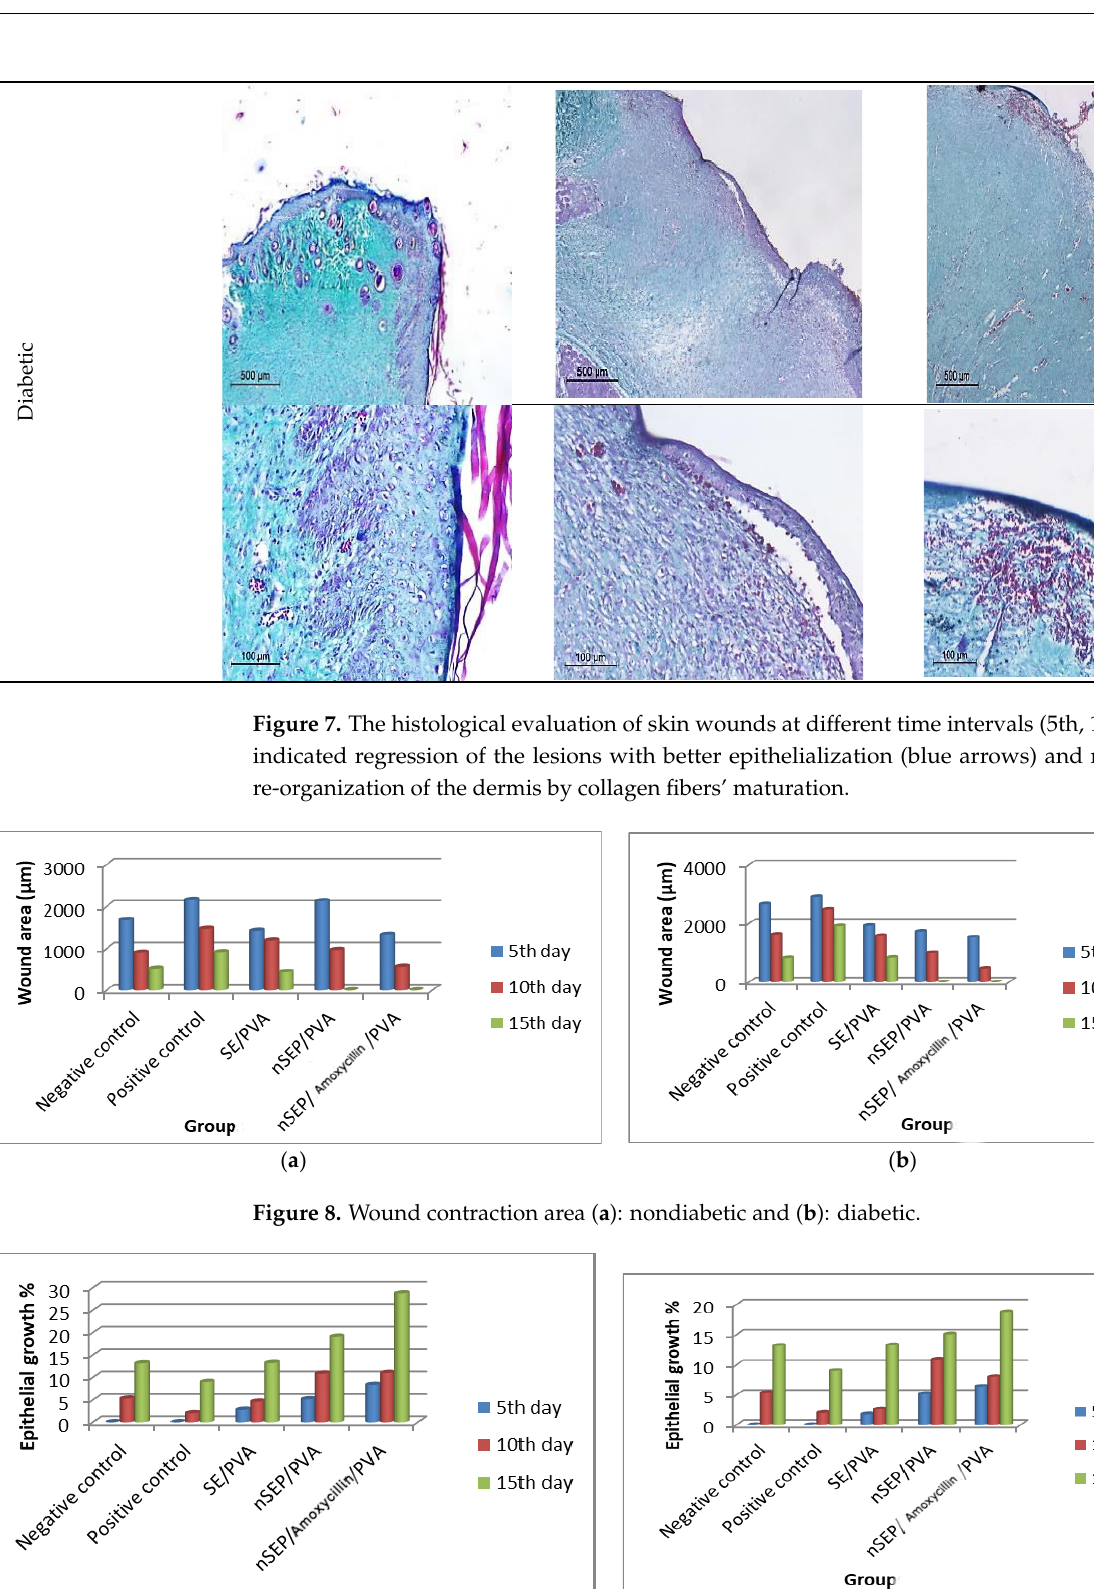
Figure 9. Percentage of epithelial growth using the potent sericin polymeric nanoparticles ( a ): nondi- abetic and ( b ): diabetic.